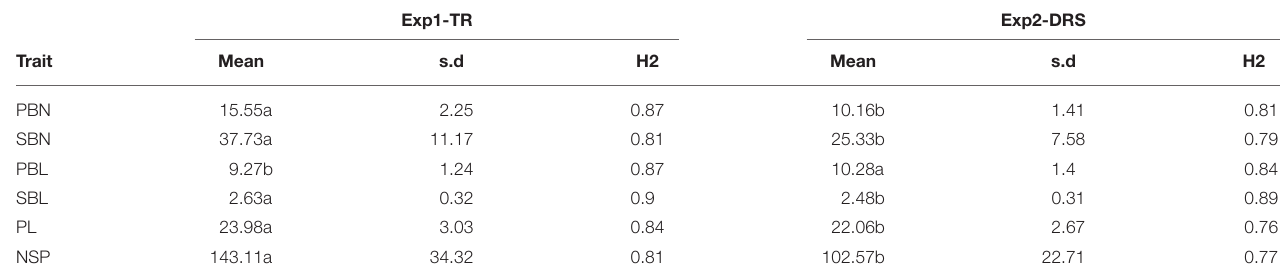
TABLE 2 | Means and broad sense heritability for each trait measured in both experiments. Exp1-TR Exp2-DRS Trait